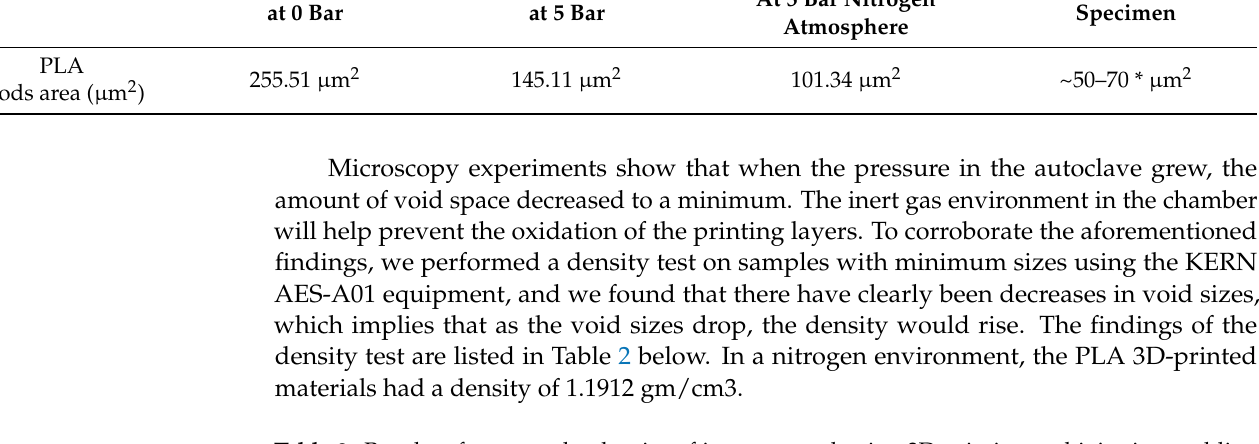
Table 2. Results of tests on the density of items created using 3D printing and injection molding under various pressure conditions in the